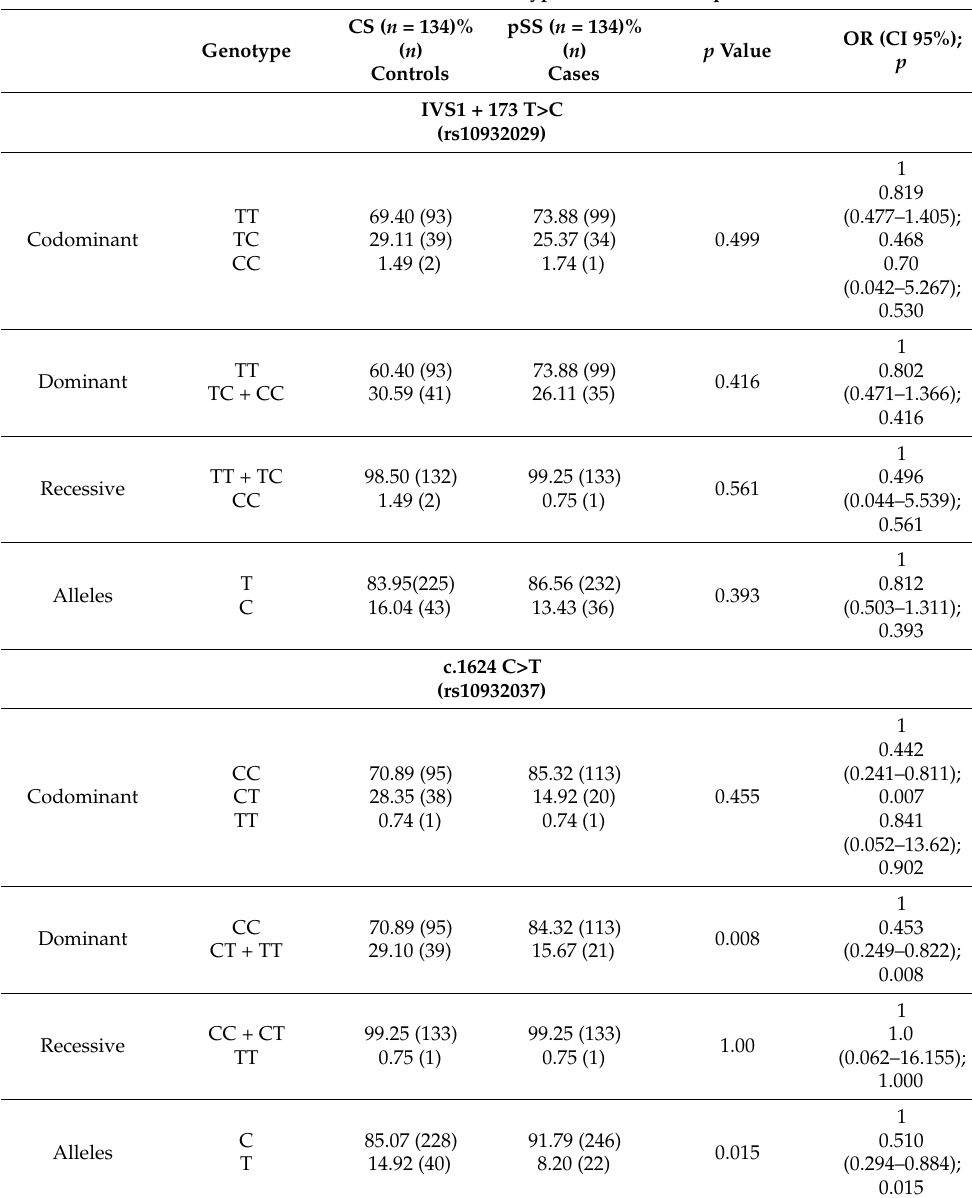
Table 2. ICOS allelic and genotype frequencies. Observed and expected frequencies in all polymorphic sites were in Hardy–Weinberg equilibrium. Significant p values are shown in bold. OR (odds ratio), CI (confidence interval), pSS (primary Sjogren Syndrome), CS (control subjects). The p -value was calculated by a Chi-squared ( χ 2